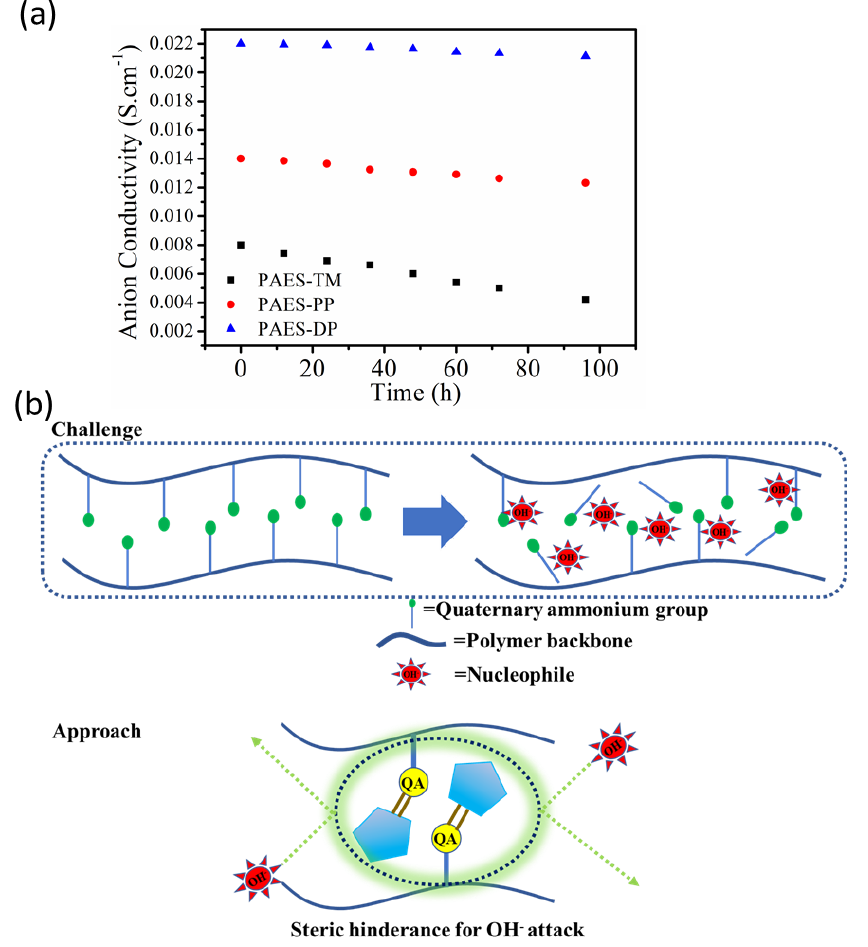
Figure 4. ( a ). Anion conductivity of the membrane as a function of time in alkaline solution and ( b ) the possible mechanism associated with the steric hindrance effect against nucleophiles by the bulky functional groups.